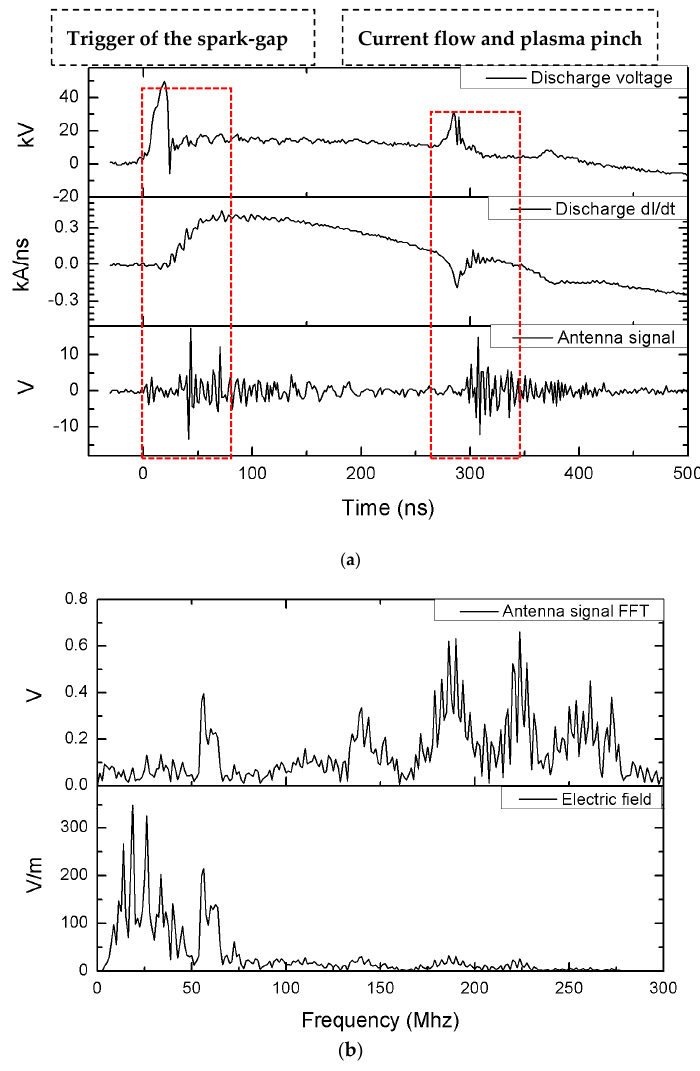
Figure 7. Time evolution of the electrical signals in the experiment; ( a ) Signals from the PF-400J voltage divider ( top ), PF-400J Rogowski coil ( middle ) and dipole antenna connected to the oscilloscope ( bottom ); ( b ) FFT of the signal detected by the antenna ( top ) and the estimated electric field with the AF ( bottom ).